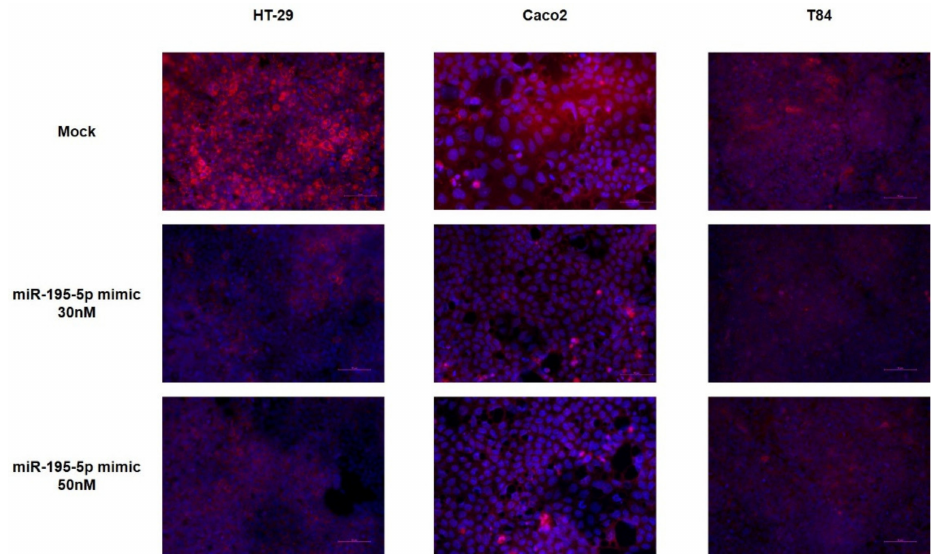
Figure 3. Immunofluorescence staining of cell monolayers exposed to TNF- α and transfected with miR-195-5p mimic at 30 and 50 nM. The immunofluorescence staining shows the same protein expression pattern of western blot analysis. The images were acquired at 20 × magnification. Scale bar represents 50 µ m.